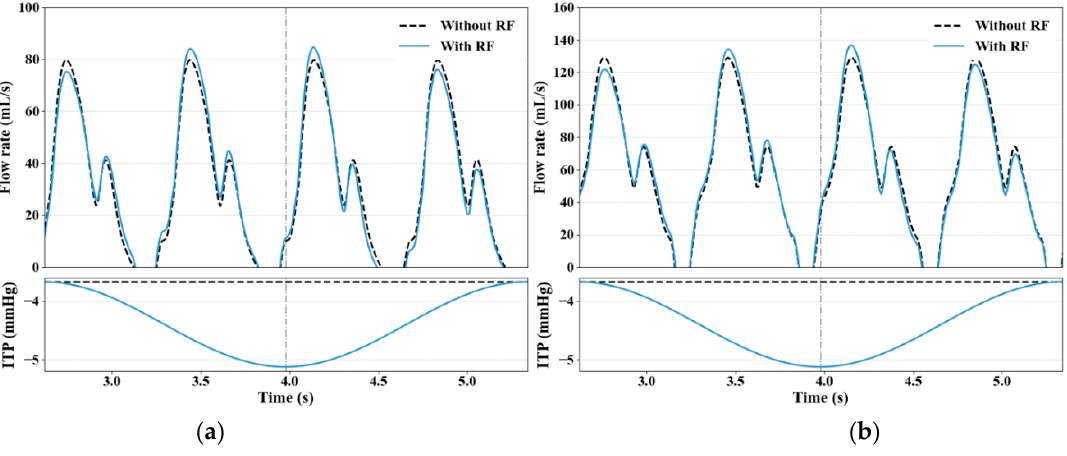
Figure 6. Flow rates and ITPs in SVC ( a ) and IVC ( b ) of an adolescent subject with/without RF effect.